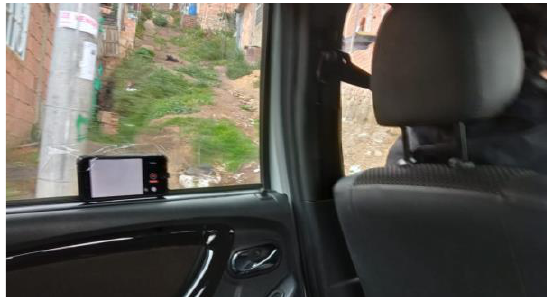
Figure 5 . Pictures of the fieldwork by